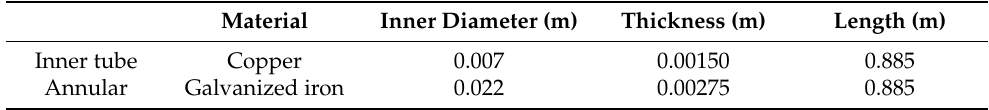
Table 5. Double-pipe heat exchanger